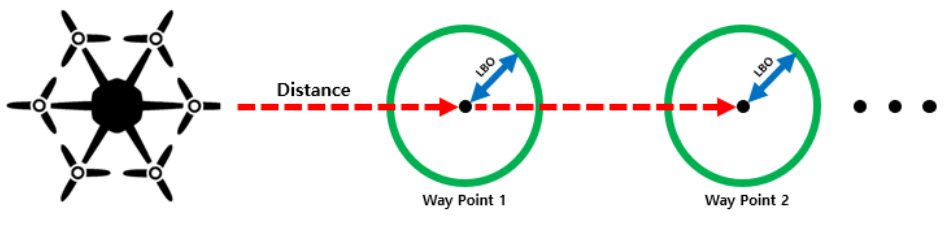
Figure 7. An example of driving waypoint update.